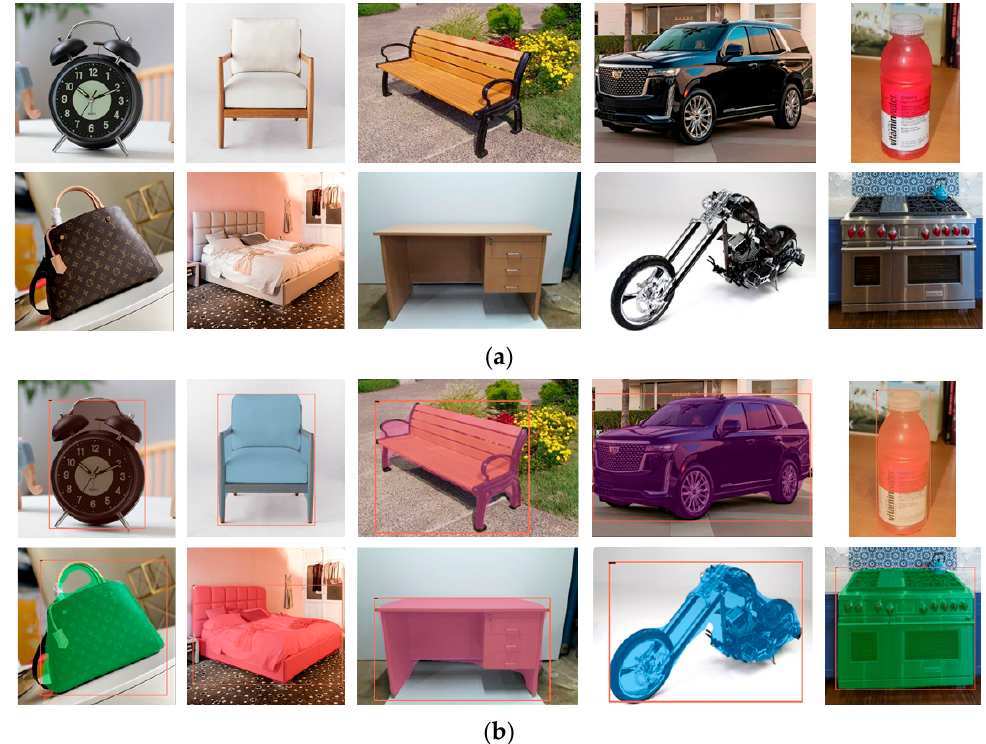
Figure 7. Example images of ten test objects. Clockwise direction from the top-left: Clock, Chair, Bench, Car, Bottle, Bag, Bed, Desk, Motobike, and Oven. ( a ) RGB input images ( b ) Detection and semantic segmentation results.